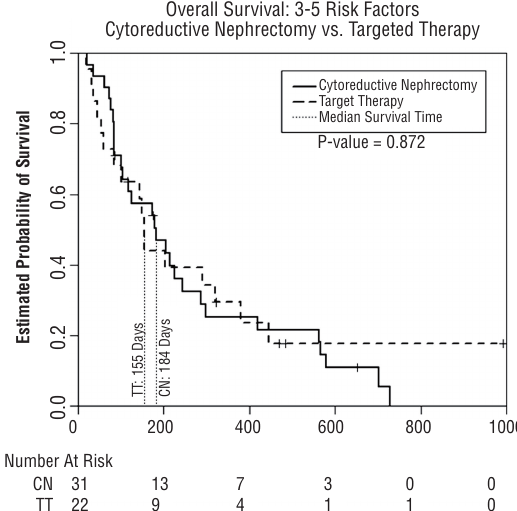
figure 3 - kaplan-Meier estimated survival comparing patients in cytoreductive nephrectomy group (cn) to targeted therapy group (TT) for patients with three to five risk